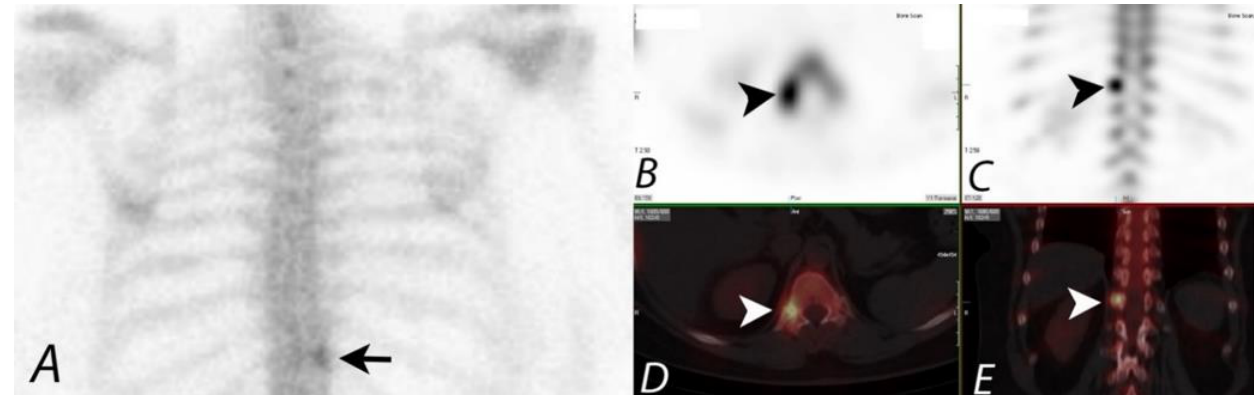
Figure 2. Patient presenting with chronic right sided mid back pain. 99m Tc MDP bone scan planar posterior spot view ( A ) of chest demonstrates a focal area of uptake (black arrow) in the lower thoracic region in paramedian location on the right side. SPECT images in axial and coronal planes ( B , C ) confirm the focal uptake localizing to the posterior element (black arrowheads), though it is unclear if this represents activity within the posterior aspect of the vertebral body, pedicle, or within the facet joints. Fused SPECT/CT images ( D , E ) in axial and coronal planes accurately localize the accumulation of the tracer activity to the costovertebral junction on the right side (white arrowheads), likely due to degenerative change.